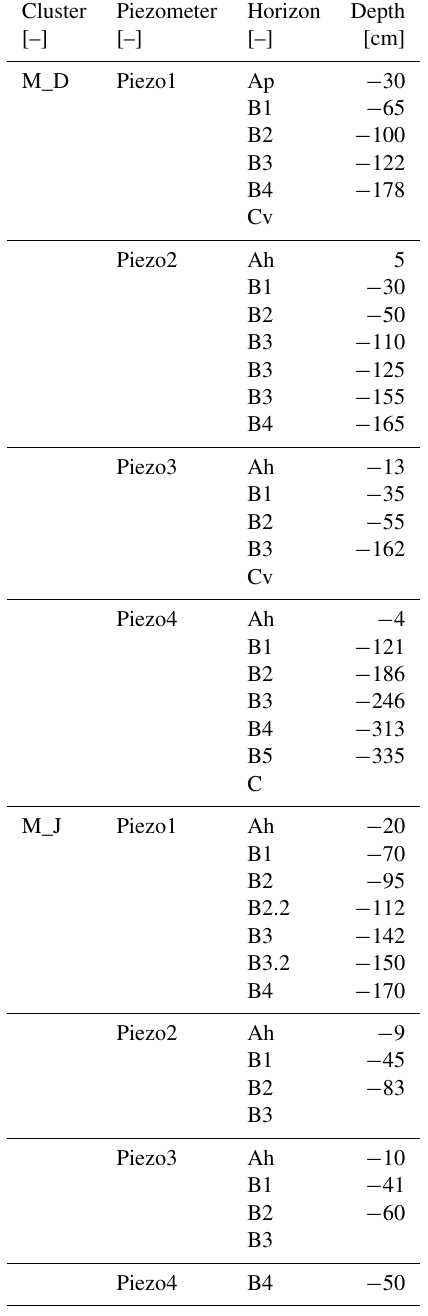
Table A3. Soil horizons of the